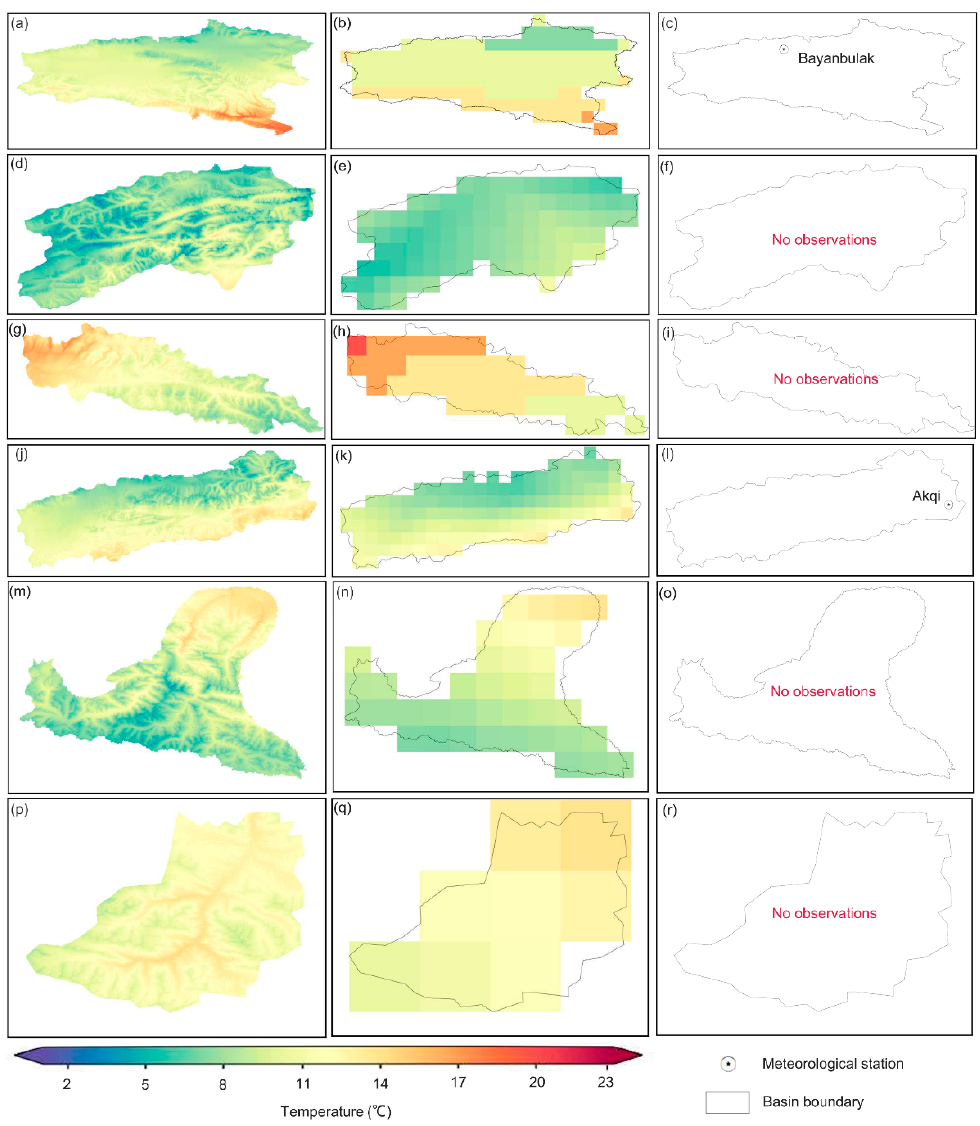
Figure 5. ( a – c ), comparison of downscaled temperature (90 m × 90 m), ERAT (0.125° × 0.125°), and observations in the KRB; ( d – f ) KuRB; ( g – i ) KaRB; ( j – l ) TRB; ( m – o ) MRB; and ( p – r ) URB; ( a , d , g , j , m , p ) are downscaled temperature; ( b , e , h , k , n , q ) are ERAT; ( c , f , i , l , o , r ) are observations .